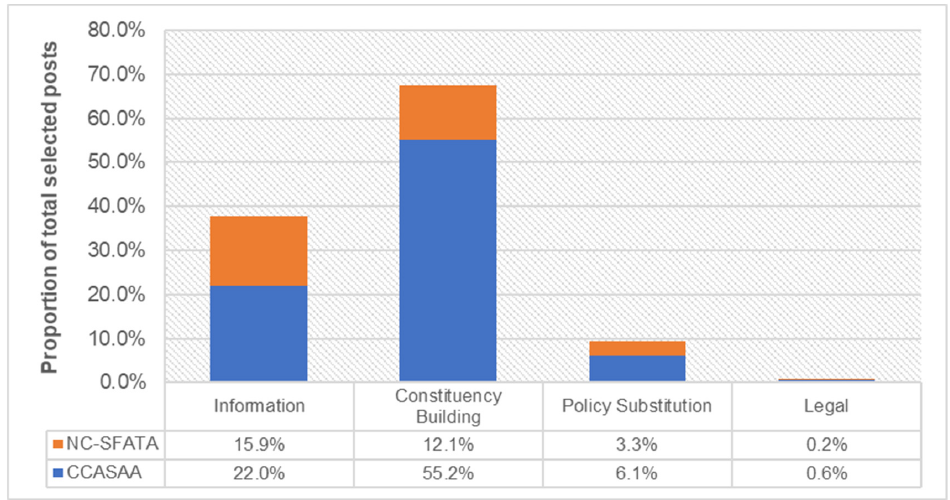
Figure 1. Content thematic